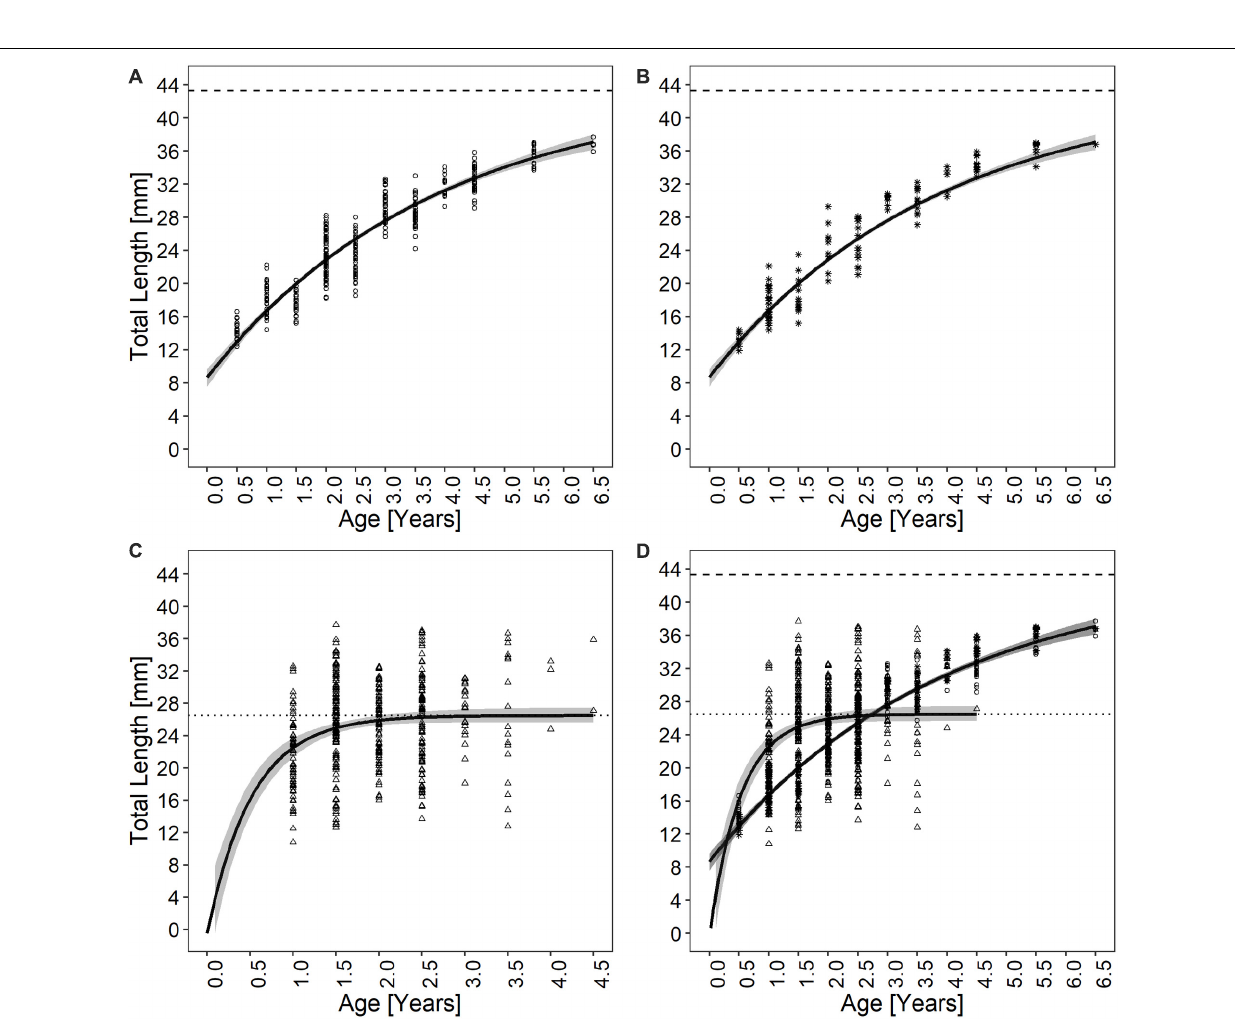
Frontiers in Marine Science |